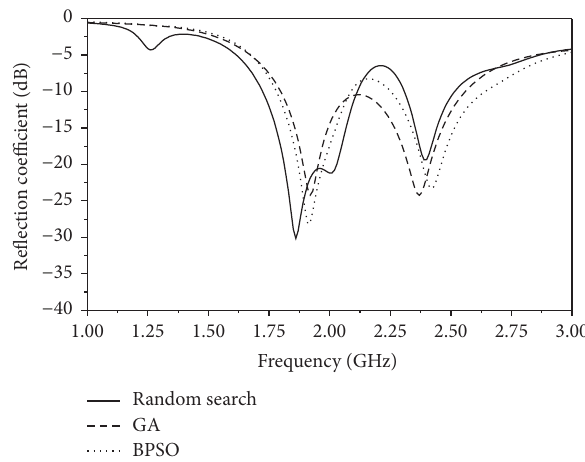
Figure 3: Simulated reflection coefficients of the optimized patch antennas corresponding to the GA, the BPSO, and the random search algorithm.